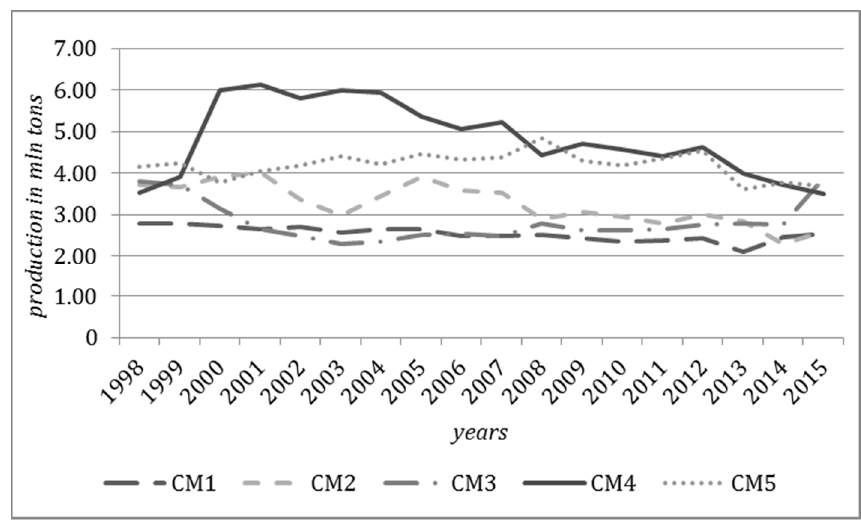
Figure 3. Production of the examined coalmines over the period 1998–2015 (mln tons). Source: own work. Energies 2017 , 10 , 1480